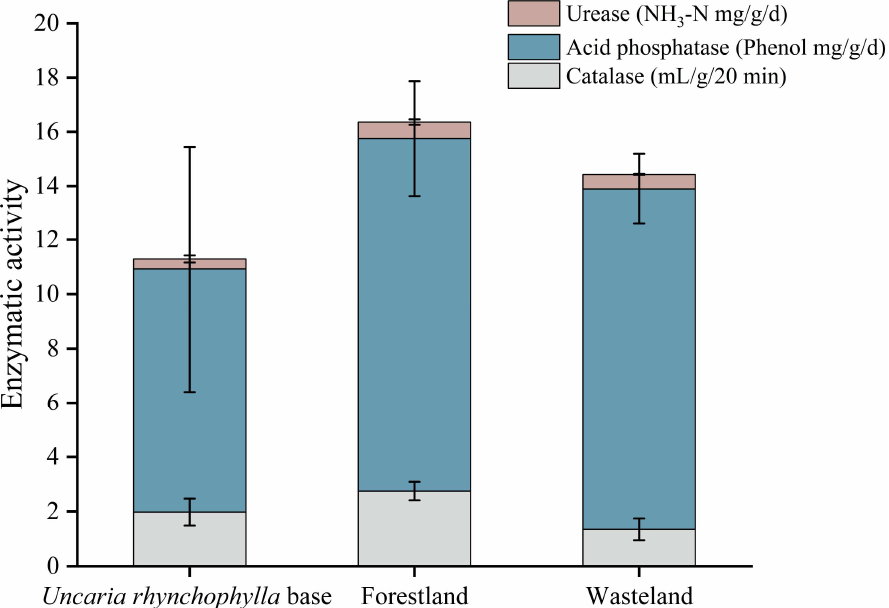
Figure 2. Enzyme activity of soil under different land use patterns.